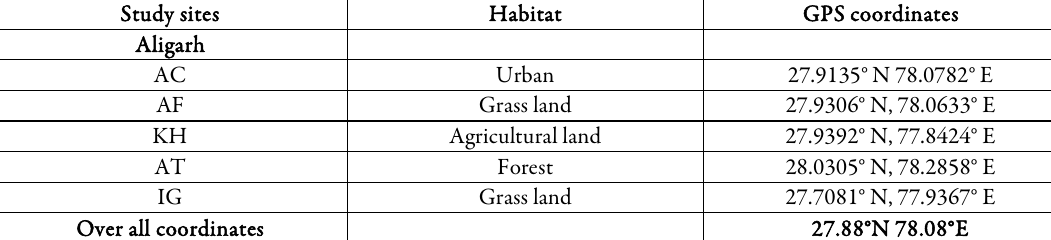
Table 1. Overview of survey sites Study sites